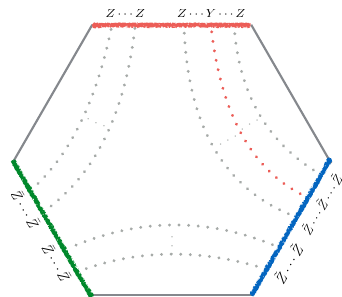
Figure 6 . For Y-excitation on the top spin chain case, the magnon can be contracted with only the vacuum ~ Z . Therefore the structure constant C 1 (cid:14)(cid:14) of the 1-magnon wave function.